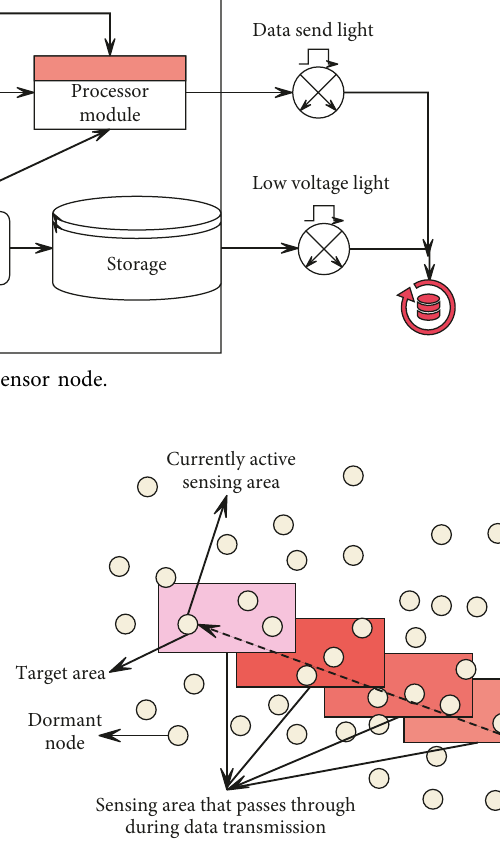
Figure 8: Network activity area in wireless sensor network.